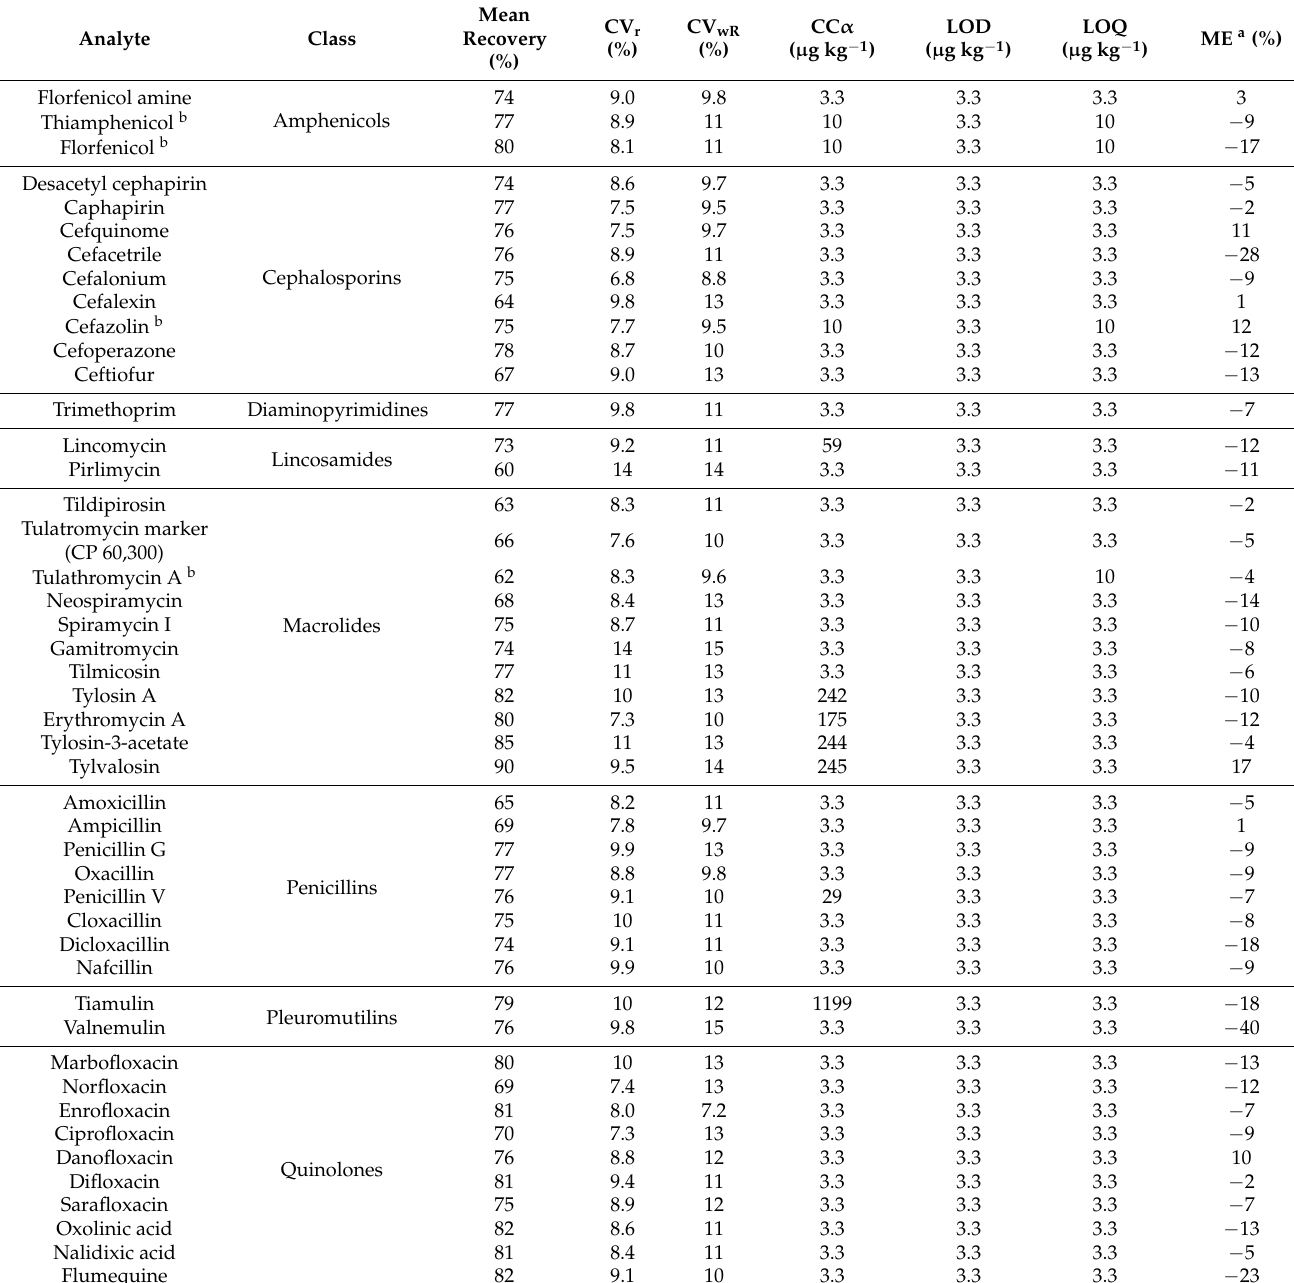
Table 1. Validation performances of the investigated analytes, sorted by class and elution